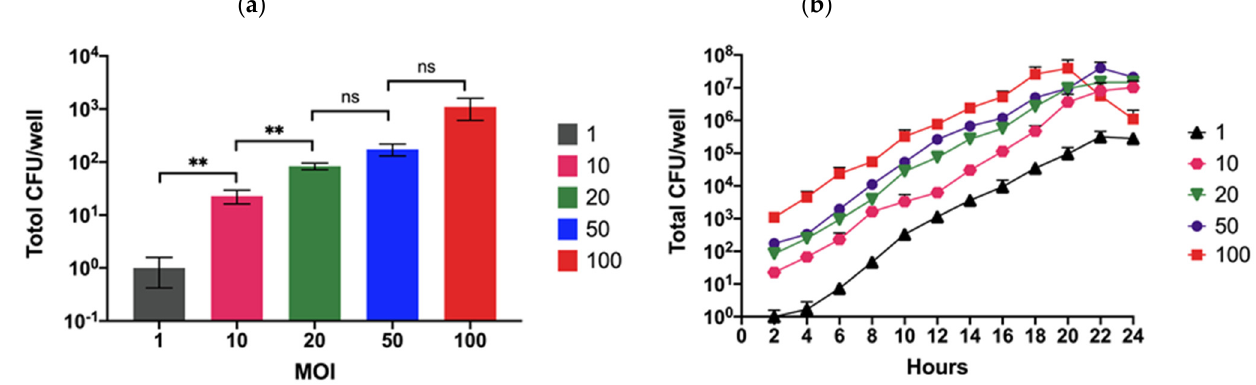
Figure 1. Effects of MOI on invasion and replication of B. pseudomallei K96243 in SH-SY5Y cells. SH-SY5Y cells were infected with B. pseudomallei K96243 at an MOI of 1, 10, 20, 50, and 100. The numbers of intracellular bacteria were determined by lysing the cells and counting viable bacteria on culture plates. Values are shown as the mean ± SEM of three independent experiments. ns: not significant, ** p < 0.01. ( a ) Total numbers of bacteria recovered from SH-SY5Y cells infected with B. pseudomallei K96243 at 2 h post-infection. ( b ) Intracellular replication of B. pseudomallei K96243 in SH-SY5Y cells at different time points.